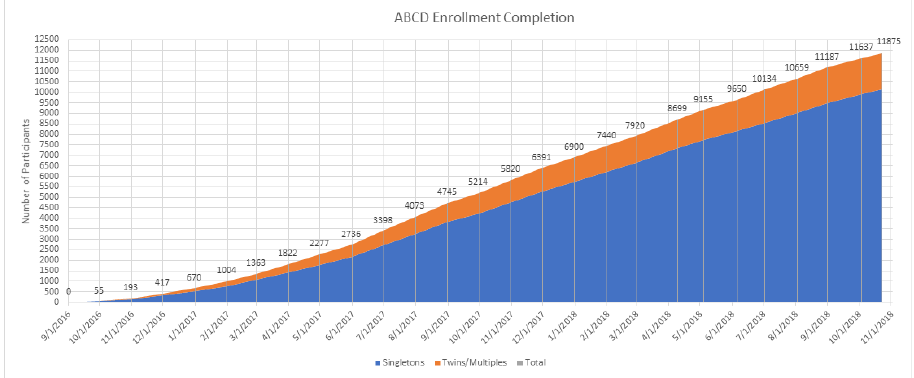
Figure 1. Enrolment to the Adolescent Brain Cognitive Development (ABCD) Study.